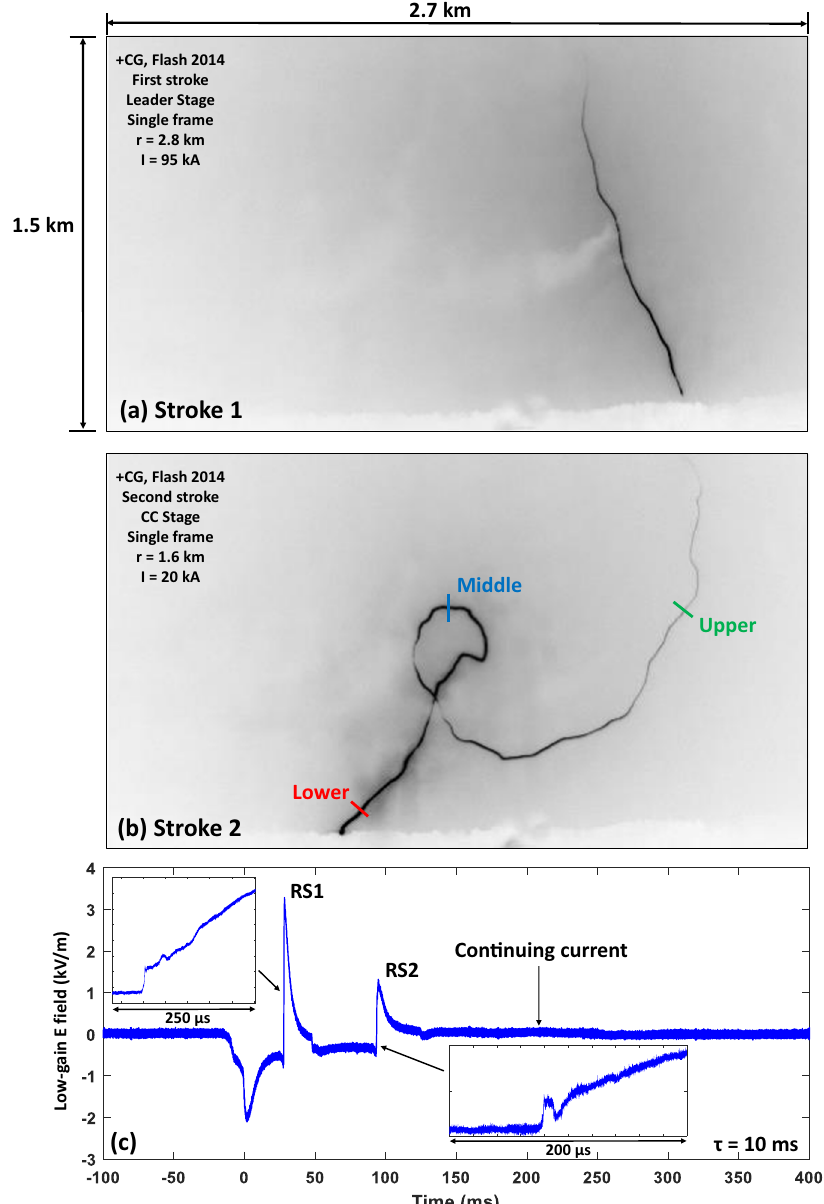
Fig. 6 Two-stroke positive Flash 2014. a 50- µ s frame of the leader stage just before the fi rst return-stroke (RS1) onset. b A single 50- µ s frame of the continuing current following RS2. Three channel cross-sections for which luminosity variations as a function of time are shown in Figs. 7 and 8 are color- coded and marked “ Upper ” , “ Middle ” , and “ Lower ” . c Low-gain electric fi eld waveform of the entire fl ash. RS2 occurred 66 ms after RS1. Continuing current (CC) is marked in c . The total CC duration based on the optical record is over 400ms (electric fi eld signature of CC is distorted by the instrumental decay, τ = 10